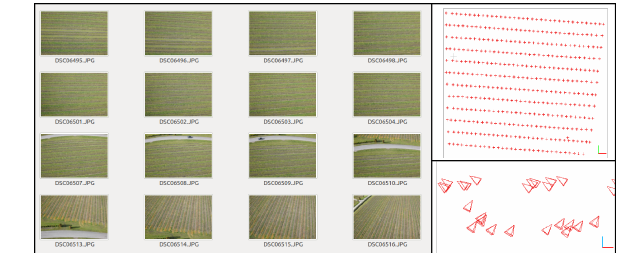
Figure 12. The Oblique dataset. Images acquired with a 45 ◦ oblique angle mounted camera.